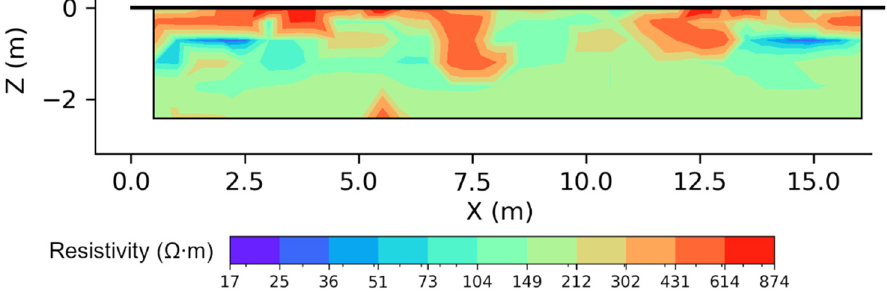
Figure 2. The inverted resistivity model, used as the reference model in the uncertainty analysis.